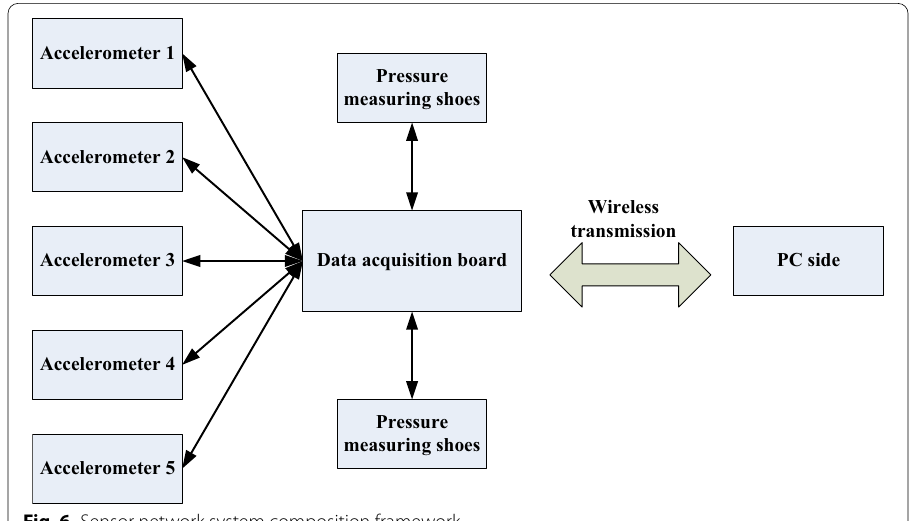
Fig. 6 Sensor network system composition